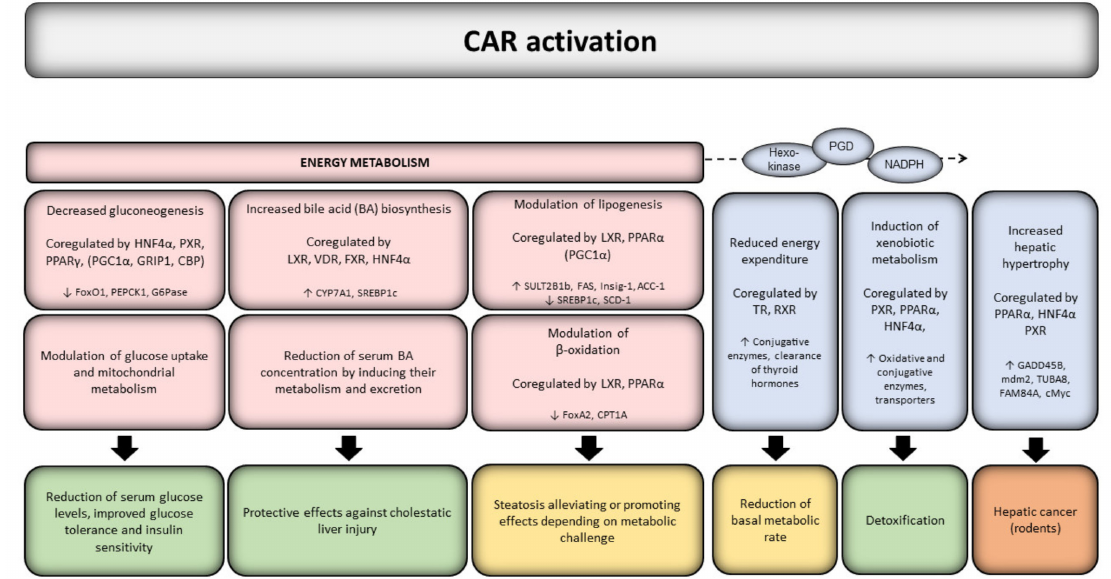
Figure 1. Schematic overview of key regulatory processes a ff ected by CAR. CAR activation modulates key metabolic processes, such as glucose and lipid metabolism and bile acid synthesis via several mechanisms and pathways (as detailed in the main text). These e ff ects depend in part on sex, nutritional status, or metabolic challenge used in animal studies. CAR-mediated induction of genes involved in glucose uptake and utilization (e.g., hexokinase, PGD) generates NADPH, which in turn supports xenobiotic metabolism. Through regulation of thyroid hormone levels, CAR can contribute to energy expenditure and weight loss. CAR alters the expression of genes associated with cell proliferation and oncogenic signaling in rodents. Positive outcomes are depicted with green, ambivalent outcomes with yellow, and adverse outcomes with orange